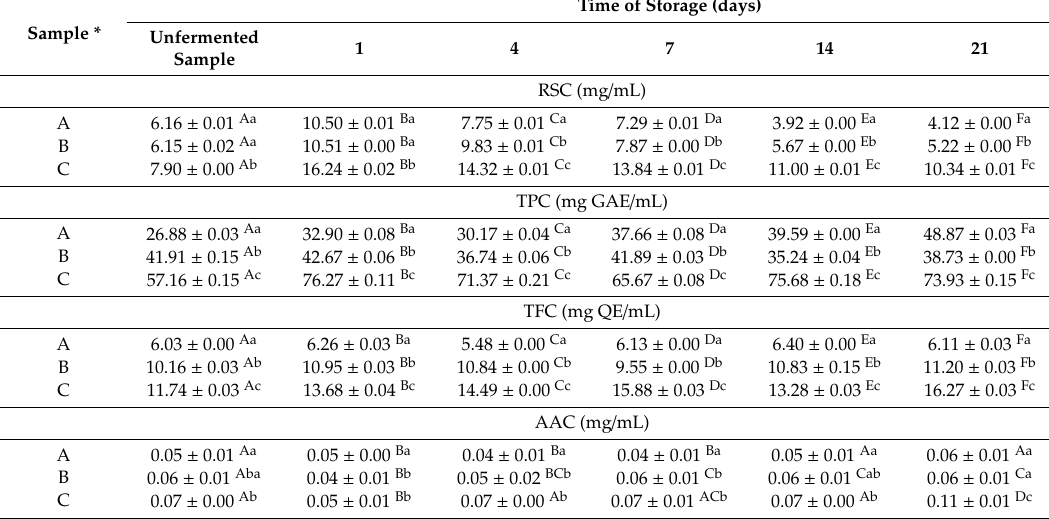
Table 5. Reducing sugars (RSC), total polyphenolics (TPC), total flavonoids (TFC), and ascorbic acid (AAC) contents of fermented beverages and unfermented (control)